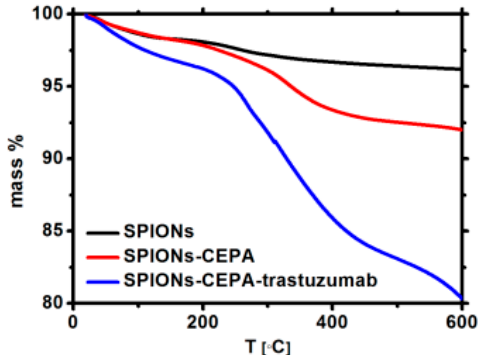
Figure 4. Thermograms of the SPIONs (black), SPIONs modified with CEPA (red), and bioconjugated (blue).